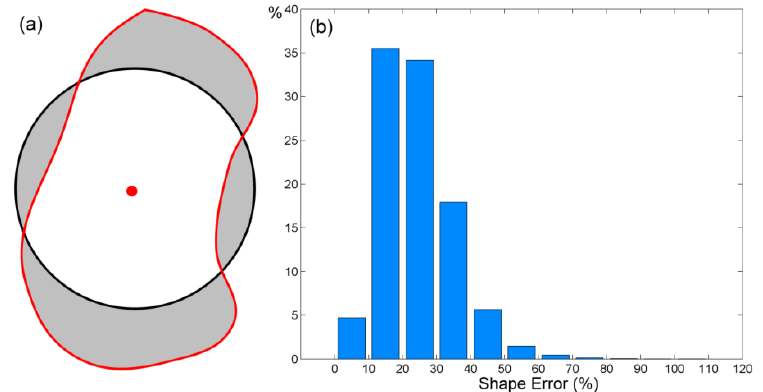
Figure 7. Sketch ( a ) and histogram ( b ) of shape error. The closed contour of the eddy edge and the ideal circle are represented by the red and black lines, respectively. Area deviations are the sum of the shaded regions, and the shape area is the area deviation expressed as the percentage of the area of the fitted